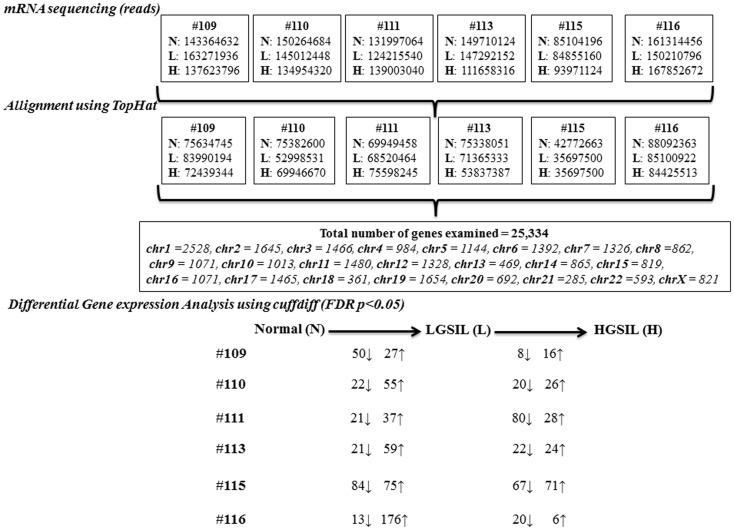
Overview of the steps involved in the mRNA sequencing analysis of normal (N), LGSIL (L), and HGSIL (H) pre-cancer lesions in six patient samples (#109, #110, #111, #113, #115, and #116).